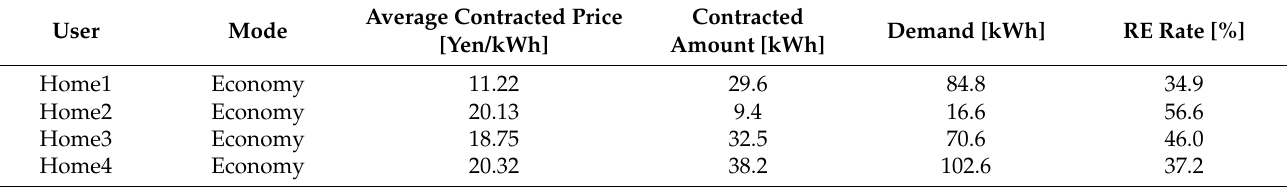
Table 3. Summary of trading results for the first